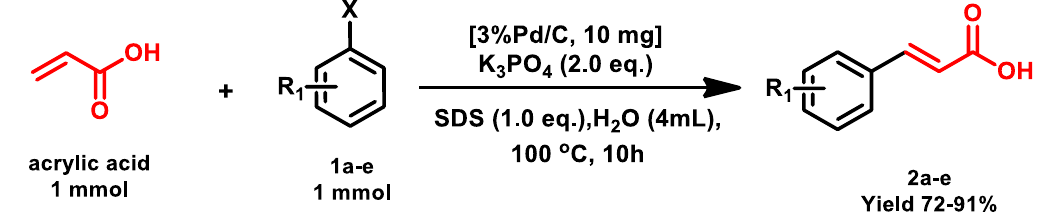
Figure 8. 3%Pd/C catalyzed Mizoroki – Heck reaction of aryl halides with acrylic acid under optimized conditions.